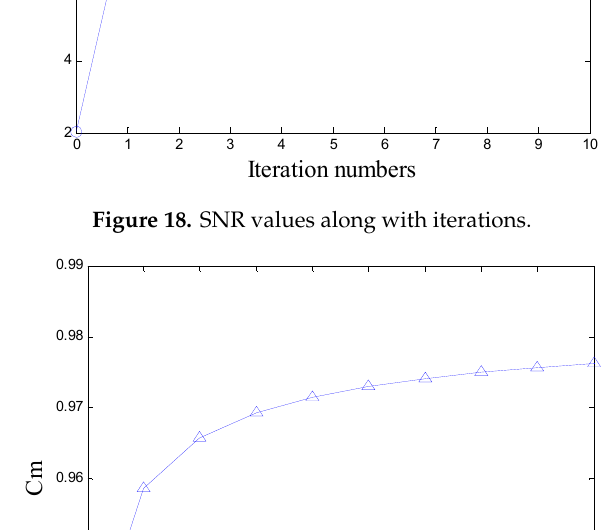
Figure 18. SNR values along with iterations.